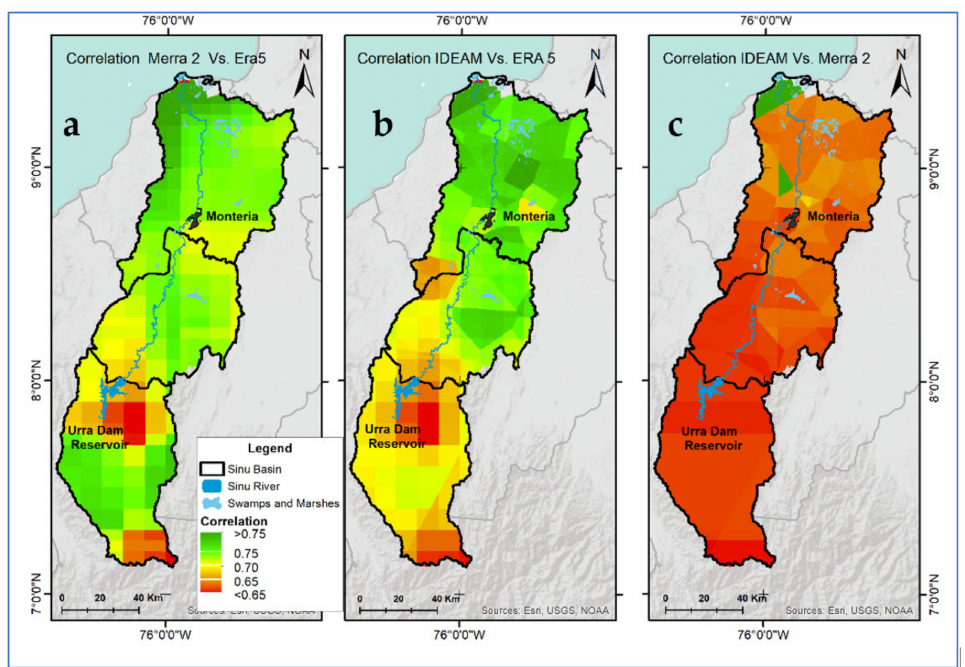
Figure 4. Correlation ( ρ S ) maps for the study area: ( a ) Correlation between MERRA2 and ERA5; ( b ) Correlation between IDEAM and ERA5; ( c ) Correlation between IDEAM and